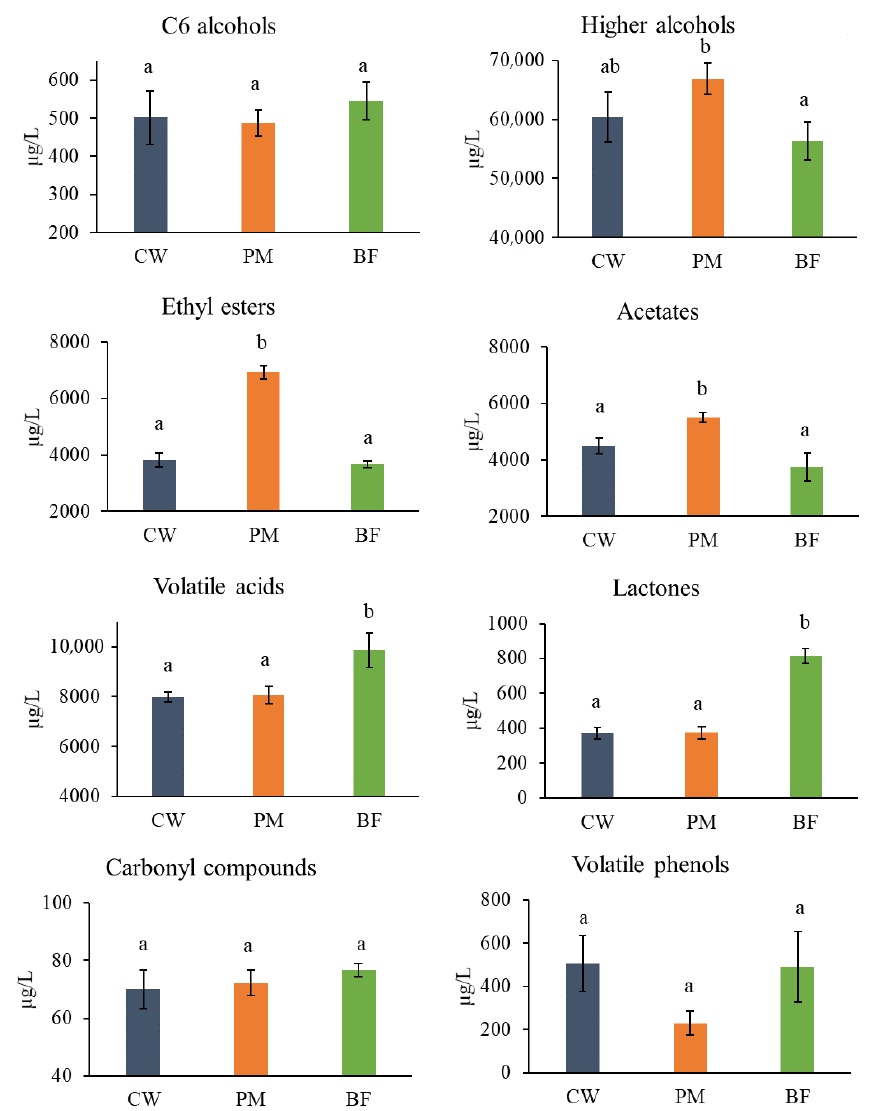
Figure 1. Concentration (μg/L) of volatile families of Maturana Blanca wines produced by conventional winemaking (CW), conventional winemaking with pre-fermentative maceration (PM) and barrel fermentation (BF). Different letters indicate statistically significant differences ( p < 0.05) according to the Tukey HSD test ( n = 3).